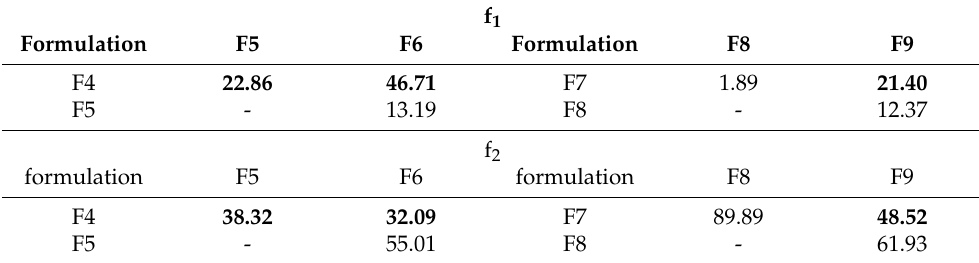
Table 2. The calculated values of the difference factor and the similarity factor.